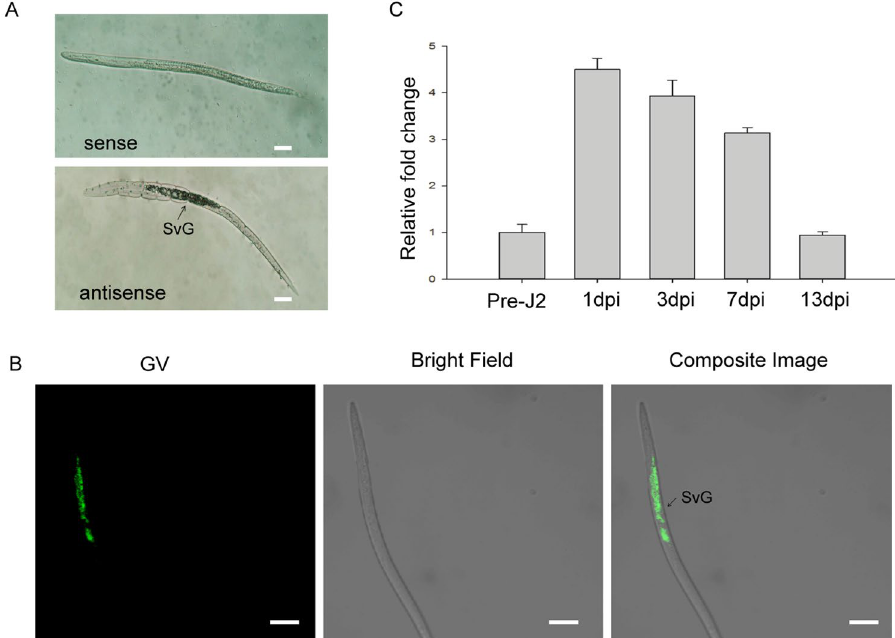
Figure 3. Spatial and developmental expression of MiISE5 . ( A ) digoxigenin (DIG)-labeled in situ mRNA hybridization. ( B ) FITC-labeled in situ mRNA hybridization. Both DIG-labeled antisense MiISE5 cDNA probe and 5 ′ end labeled with FITC cDNA probe localized MiISE5 transcripts within the SVGs. Scale bar = 10 μ m. ( C ) Developmental expression pattern of MiISE5 . The relative expression of MiISE5 was quantified using q-PCR in three different M. incognita life stages: pre-J2s, par-J2s (1–3 dpi), and J3s (7–13 dpi). Each bar represents the mean ± SD of three biological replicates; the 18 S gene was used as an internal control. dpi: days